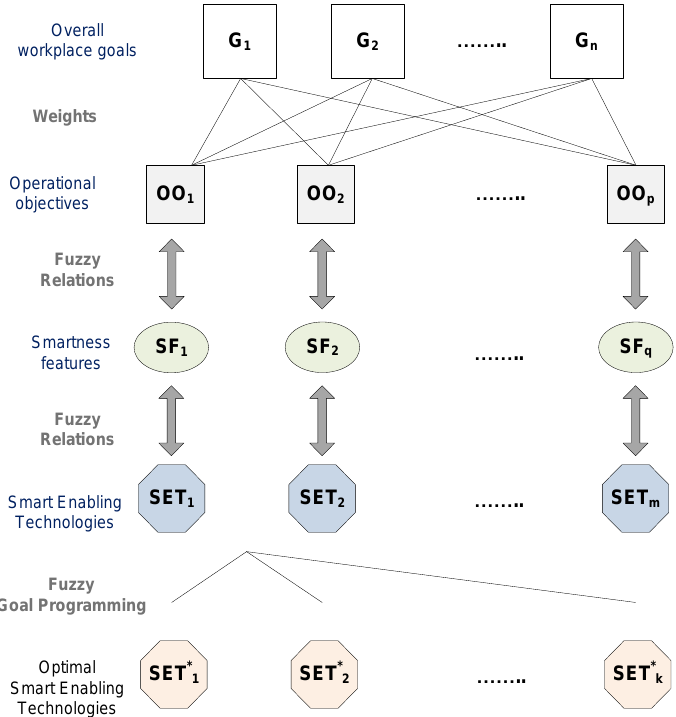
Figure 2. Smart workplace model building blocks.